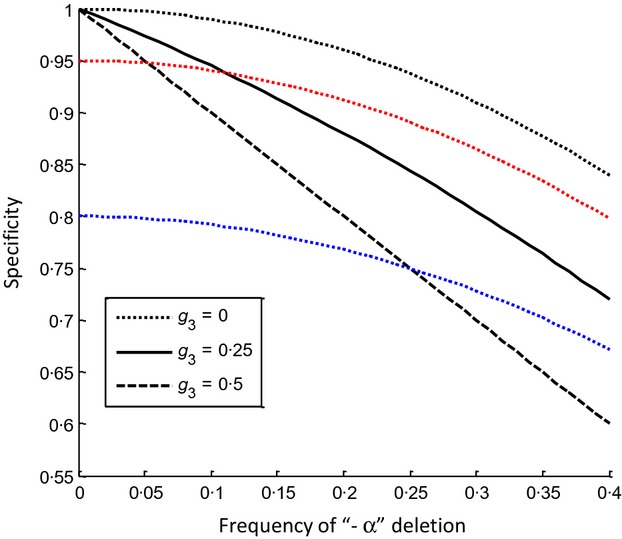
The effects of iron deficiency and alpha thalassaemia levels on the specificity of one tube osmotic fragility tests for beta thalassaemia. Parameter values were as follows: g1 = 1, g2 = 1; beta thalassaemia frequency = 0·12; SAO frequency = 0; G6PD frequency = 0. Different values of g3 are indicated by the different line styles: g3 = 0 (…); g3 = 0·25 (solid lines) and g3 = 0·5 (—). Different values of d are indicated by the different coloured lines: d = 0 (black), d = 0·05 (red) and d = 0·2 (blue).